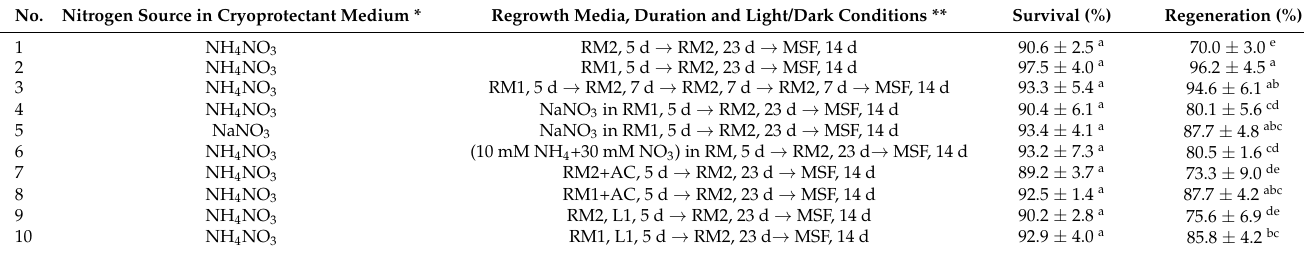
Table 2. Effect of substitution of ammonium ion and different combinations of regrowth conditions on survival and regeneration of Pogostemon yatabeanus shoot tips in the droplet-vitrification procedure. Shoot tips were cryoprotected but not